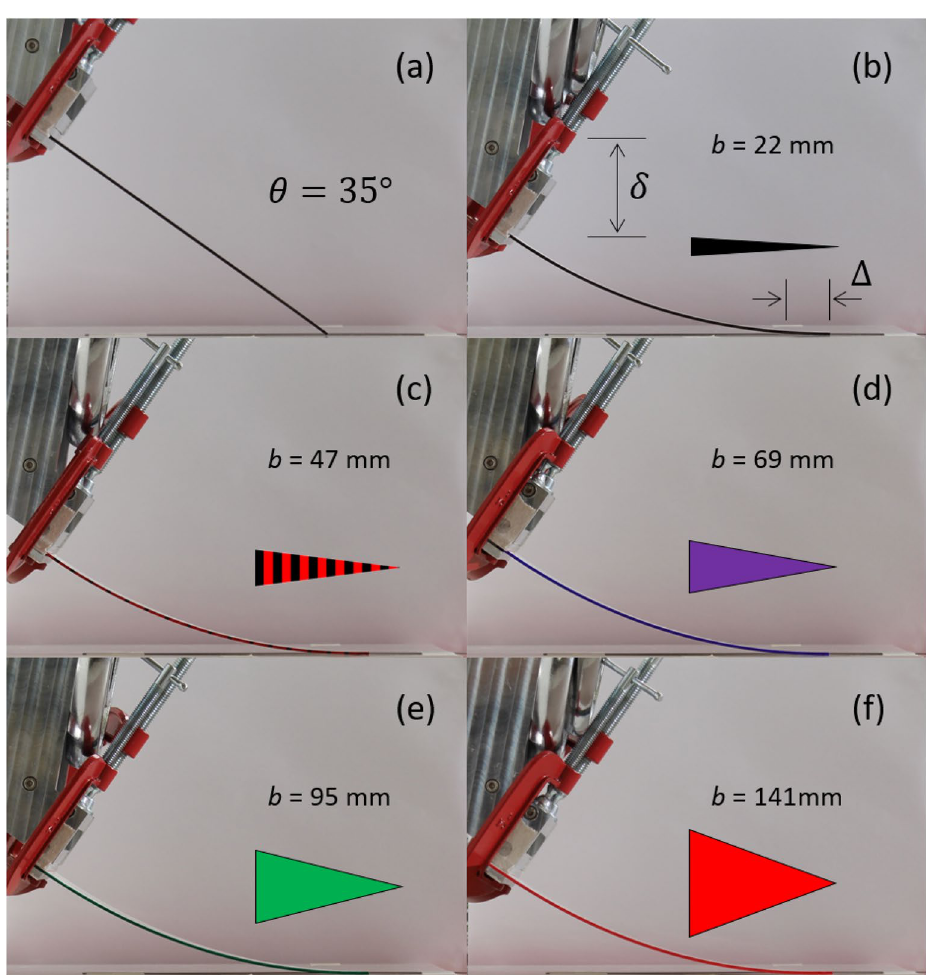
Figure 4. Photographs of the skate and overtravel of triangular cantilevers inclined at 35° to the horizontal. ( a ) A triangular cantilever in contact with the surface. ( b – f ) The triangular cantilevers are shown when the tip is tangent to the surface. In each case the length of the triangular cantilever is 190